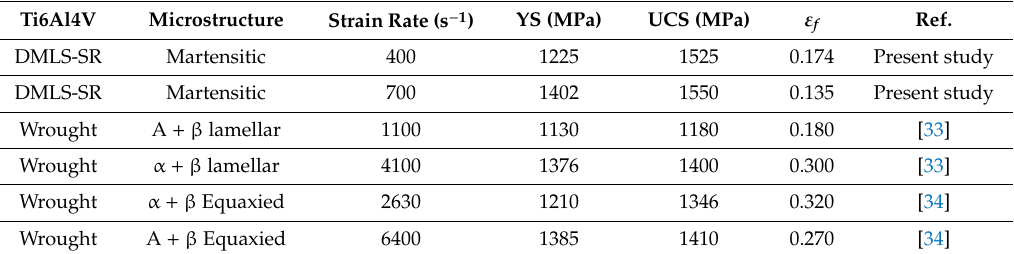
Table 5. A comparison of the flow properties of SR DMLS Ti6Al4V (ELI) samples in the present work with those reported in the literature for wrought Ti6Al4V